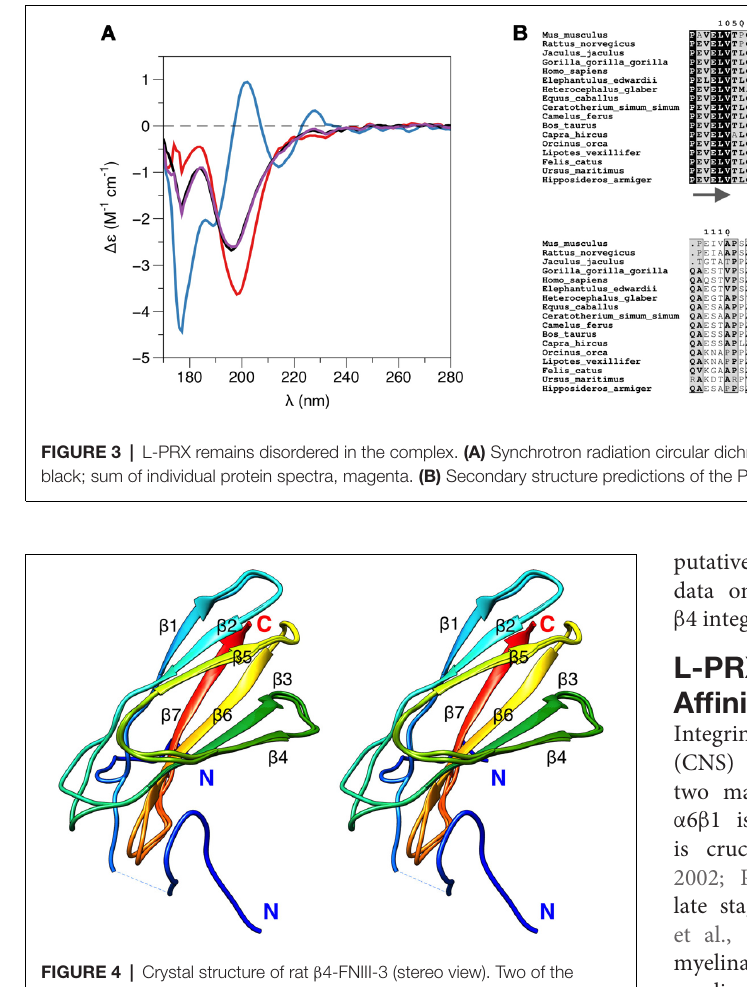
FIGURE 4 | Crystal structure of rat β 4-FNIII-3 (stereo view). Two of the four individual chains in the asymmetric unit are shown. The chain is colored from the N (blue) to the C (red) terminus. The His-tag is partially resolved at the N terminus, and takes different conformations in different monomers. Secondary structure elements are